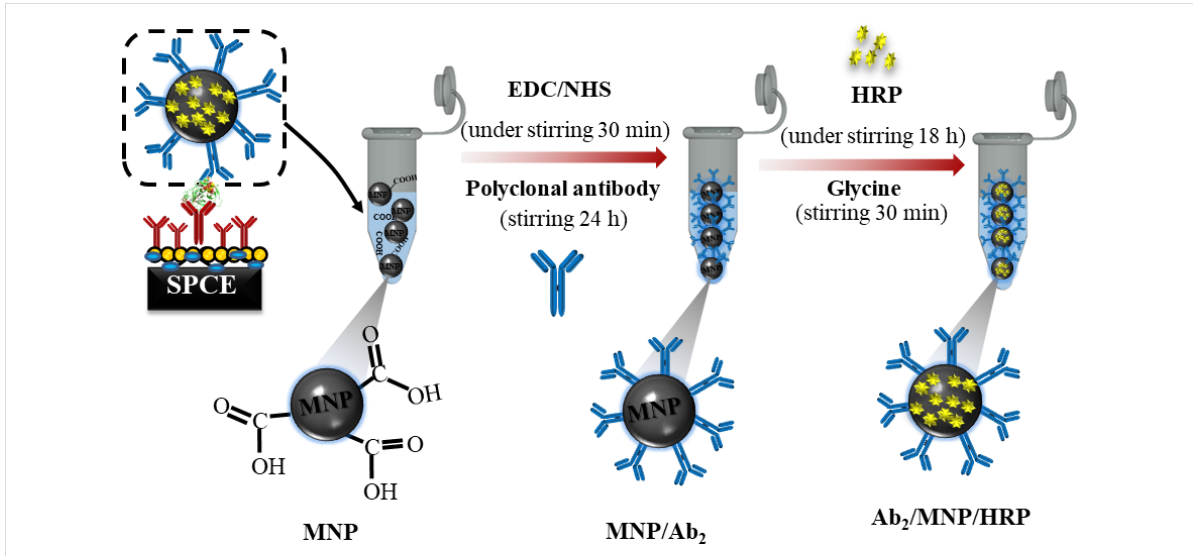
Figure 8: Preparation of the bioconjugate complex of Ab 2 and HRP (Ab 2 -MNP-HRP).